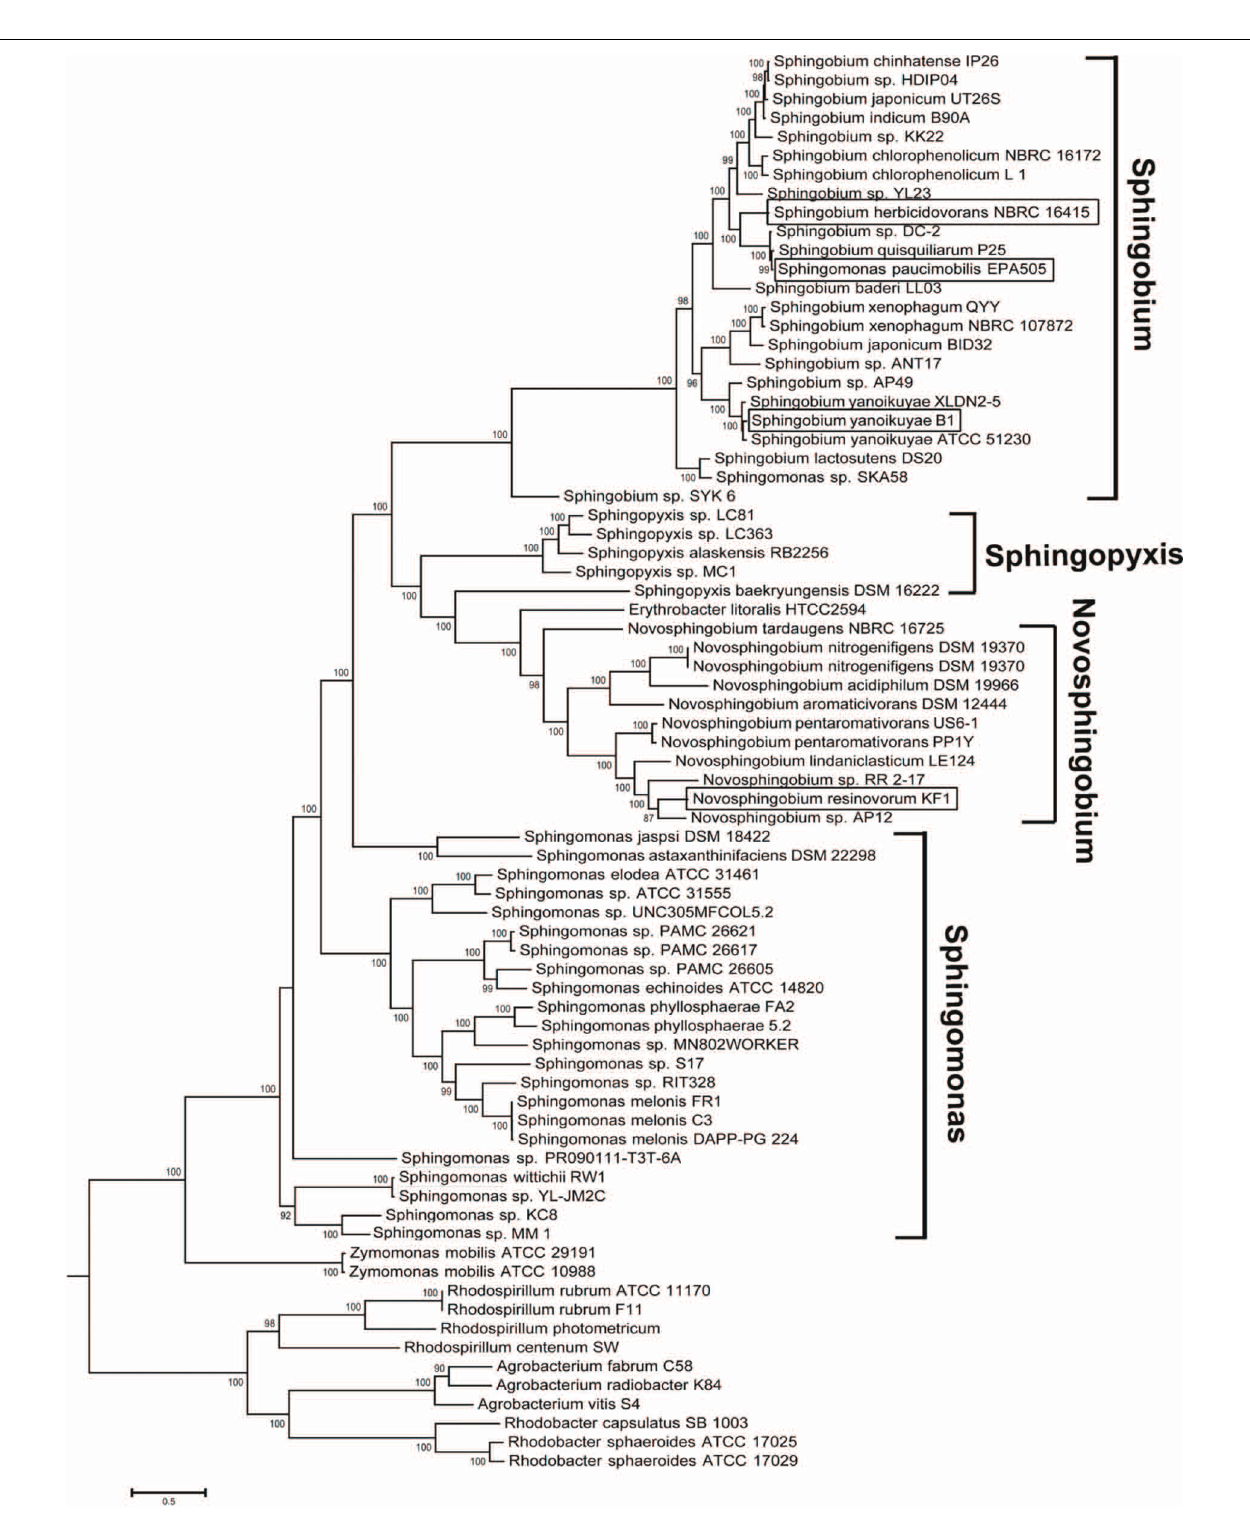
FIGURE 2 | Phylogenomic tree depicting the evolutionary relationship of currently sequenced sphingomonads based on approximately 400 conserved single-copy genes. The four whole genomes sequenced in study